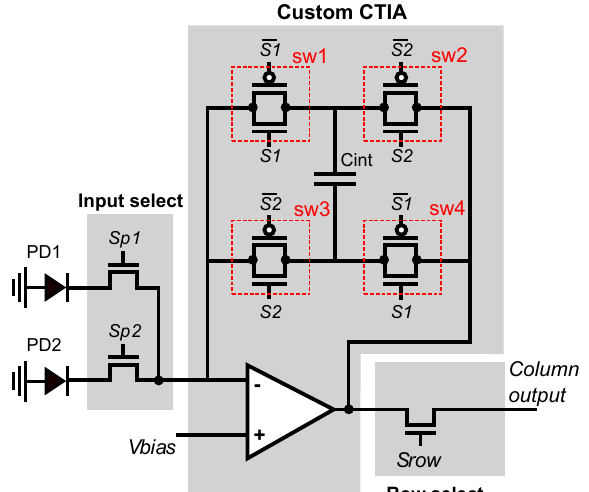
Figure 6. Schematic diagram of the configurable CTIA. The CTIA integrates the photodetector currents and outputs a voltage that represents either the pixel value or the difference between horizontally-adjacent